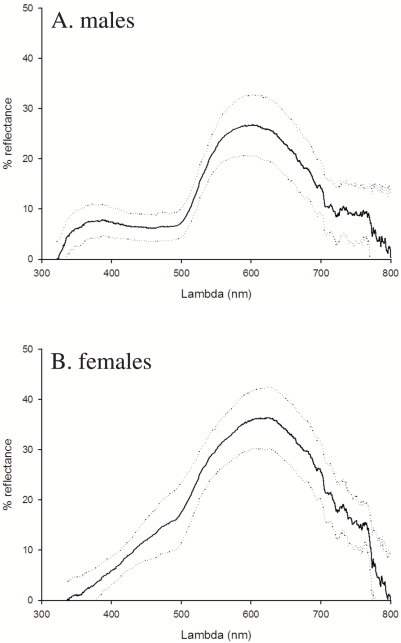
a–b. Average reflectance spectra of ventral colouration in male (a) and female (b) common lizards.The mean and SD per sex of the reflectance spectra measured at the beginning of the experiment are given.